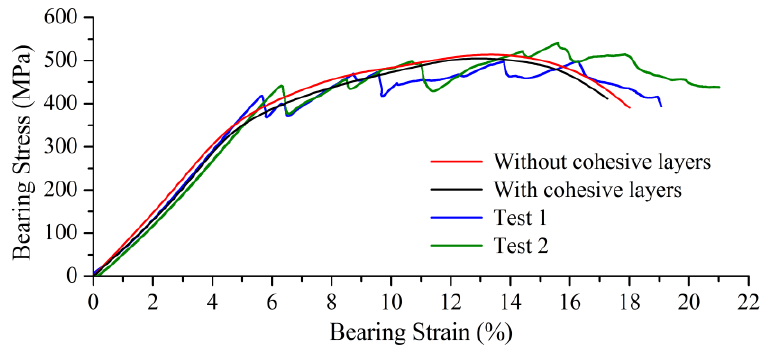
Figure 16. Experimental versus numerical bearing stress-bearing strain